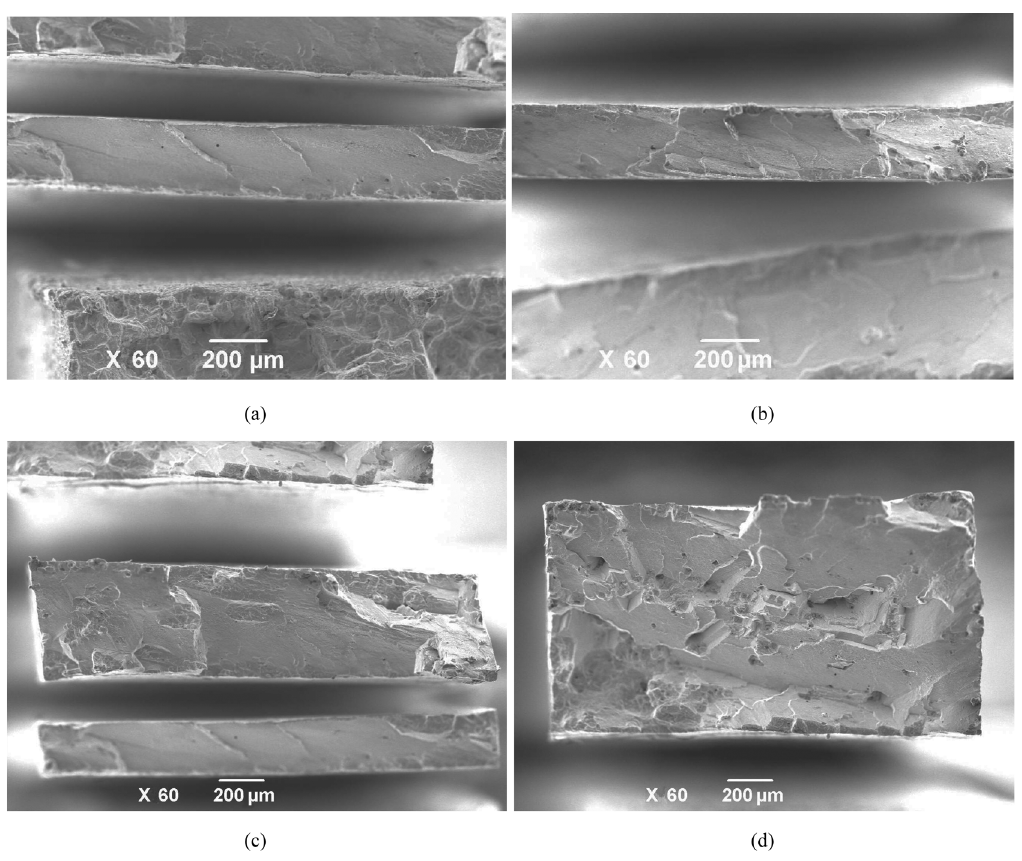
Figure 3: SEM fractograph of the specimen fracture surface. (a) δ = 0.3 mm, 760 ℃ /830 MPa; (b) δ = 0.3 mm, 760 ℃ /900 MPa, (c) δ = 0.6 mm, 760 ℃ /830 MPa and (d) δ = 1.2 mm, 760 ℃ /830